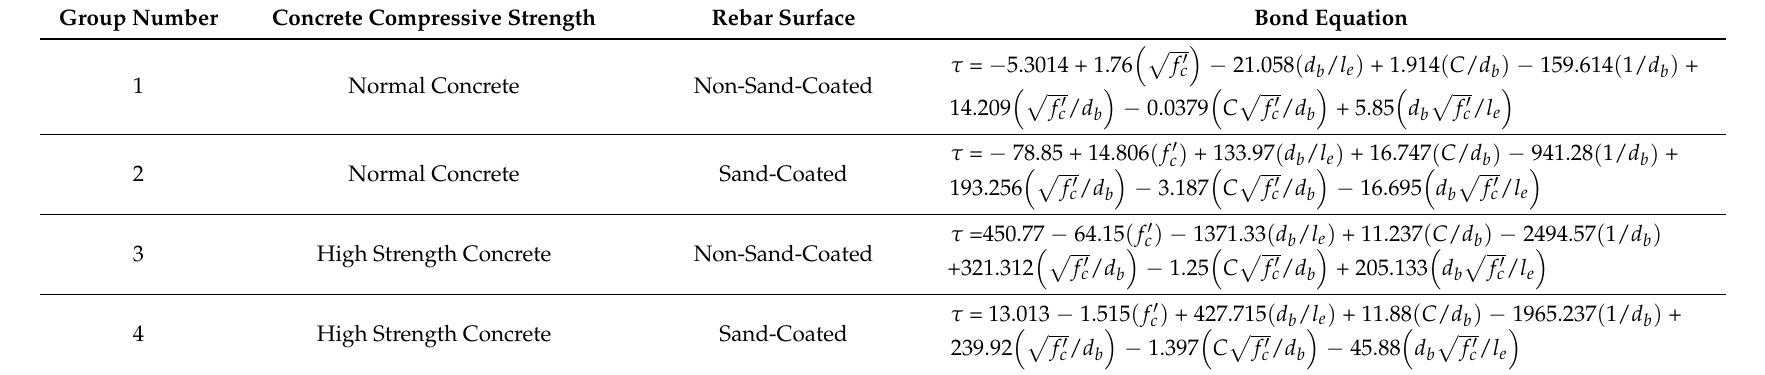
Table 2. The predictive bond equations developed in the present